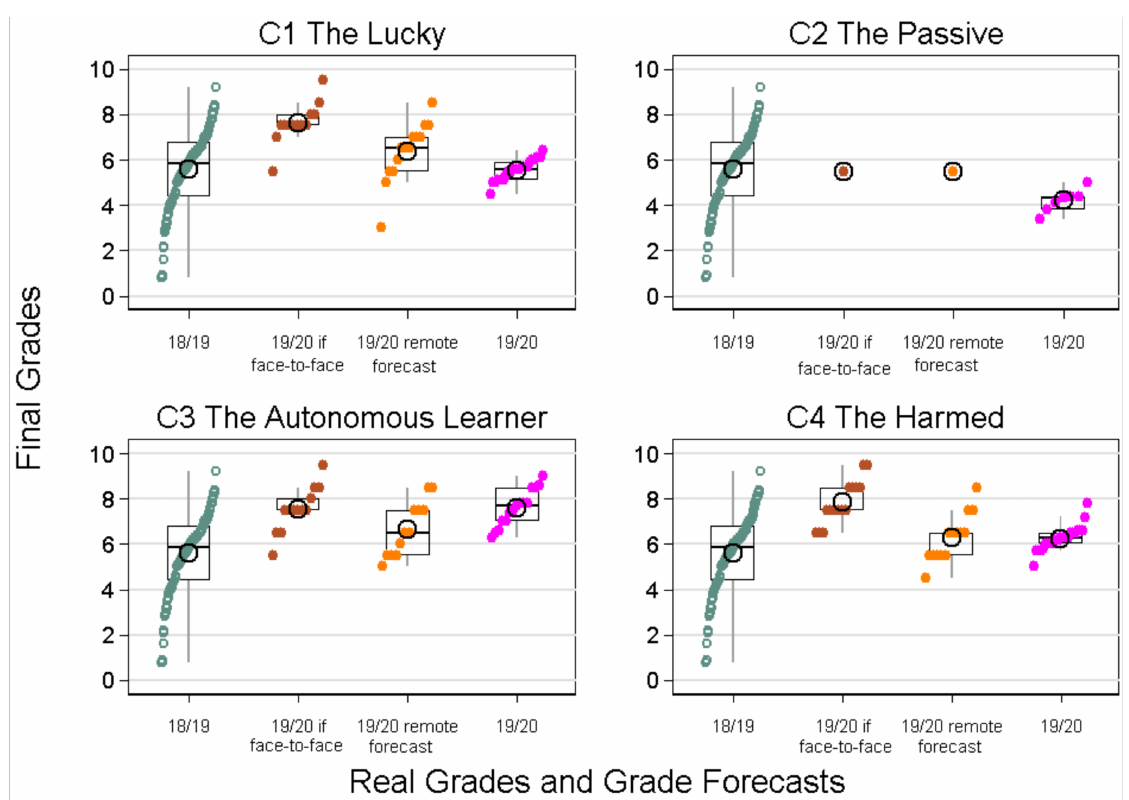
Figure 7. Students’ grade forecast and actual obtained grades vs. previous course